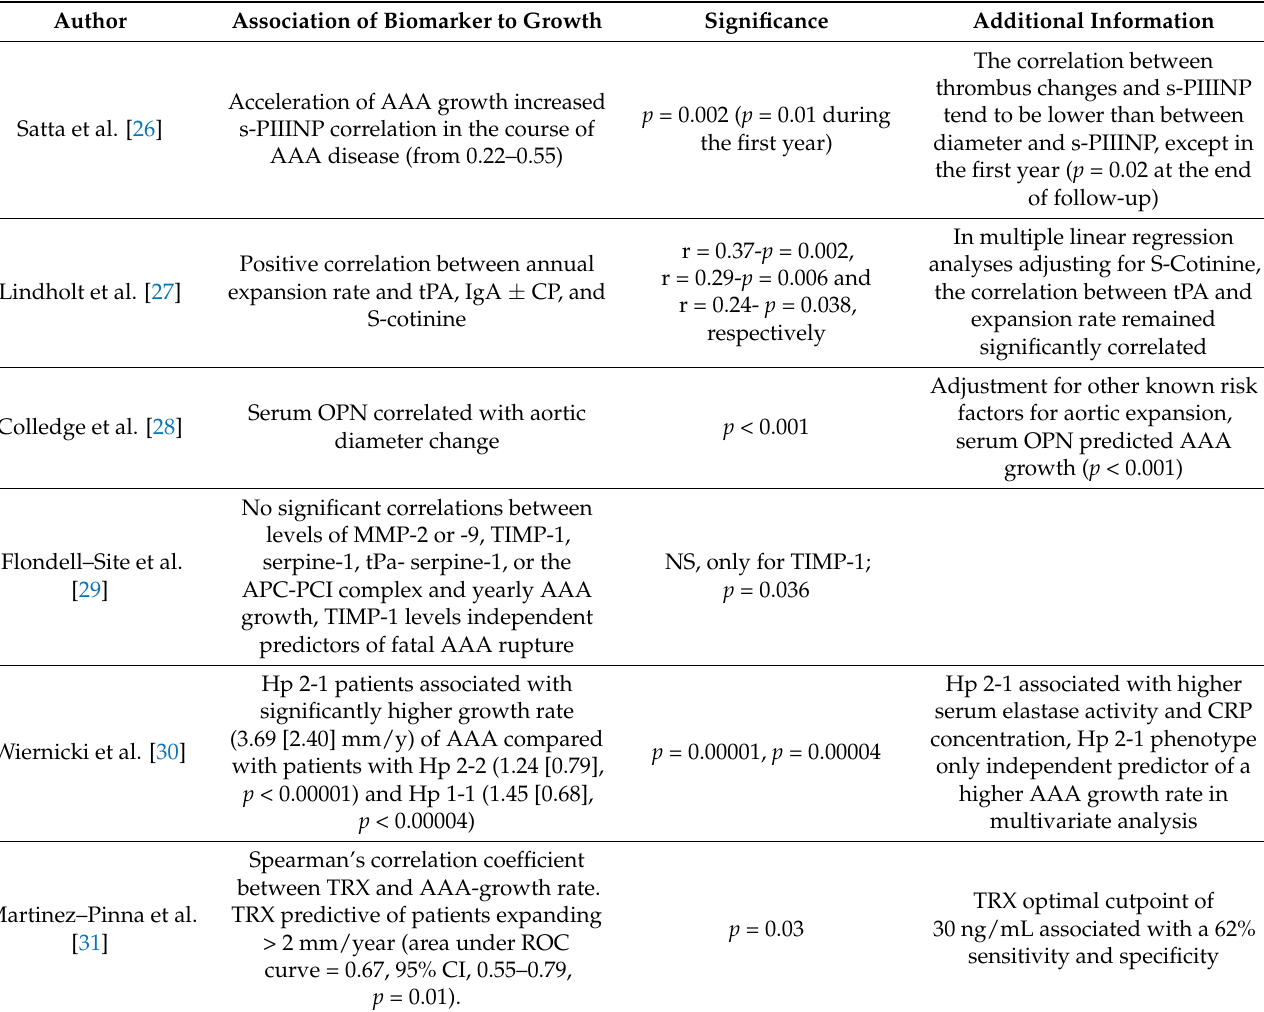
Table 6. The association between experimental biomarkers and AAA